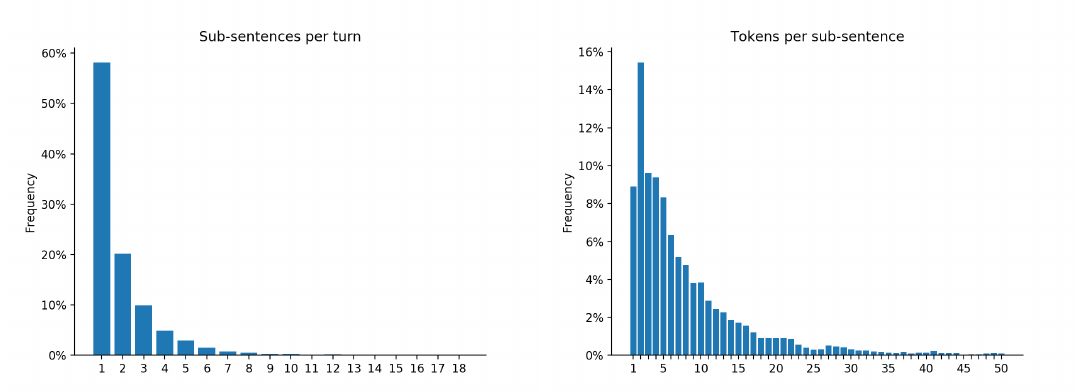
Figure 3. ( Left ) Number of subsentences per turn. ( Right ) Number of tokens per